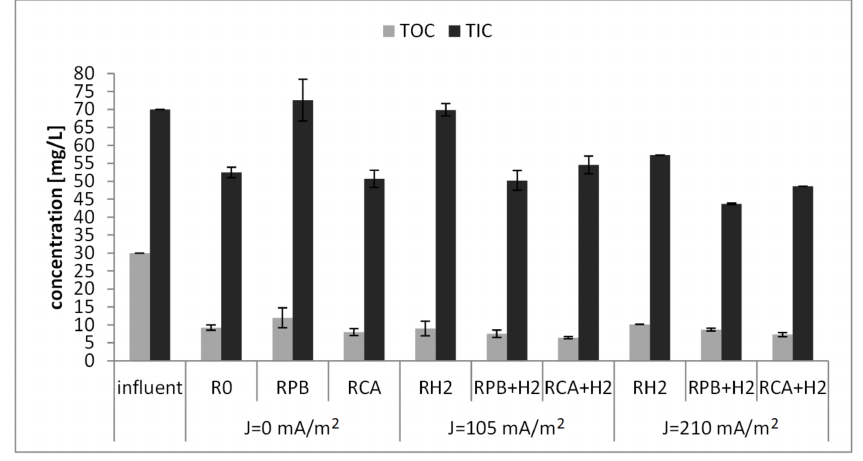
Figure 6. The concentration of total organic carbon (TOC) and total inorganic carbon (TIC) in the reactors with an electric current flow and without an electric current flow: R 0 —control reactor, without an electric current flow and without an external carbon source; R PB —reactor without an electric current flow and with a potassium bicarbonate dosage; R CA —reactor without an electric current flow and with an acetic acid dosage; R H2 —reactor with an electric current flow and without an external carbon source; R PB+H2 —reactor with an electric current flow and with a potassium bicarbonate dosage; R CA+H2 —reactor with an electric current flow and with an acetic acid